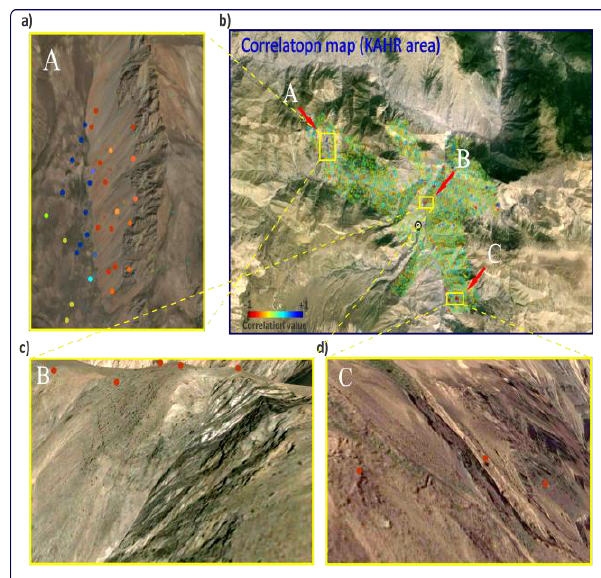
Figure 2: Correlation map for ENVISAT descending between phase and baselines due to topographic changes. For high correlated pixels (red color), visualization of topographic change due to landslide, is possible using overlay on Google earth platform. In part A, upstream region (near the crest) has negative correlation and the downstream area (close to hillside) has positive correlation due to debris accumulation.